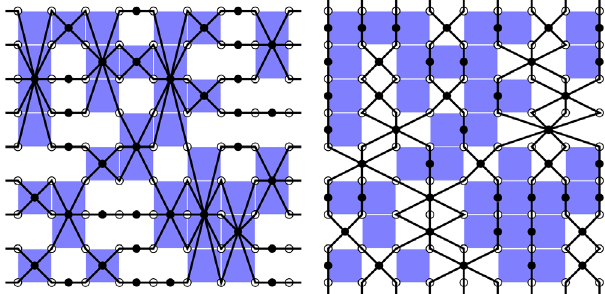
FIG. 4. The left-hand side represents the graph describing the two-body Ising model. The right-hand side represents its dual, the decoder graph. The blue squares represent cuts in the X -type stabilizers on a 9 × 9 lattice. The connectivity on the left-hand graph determines the sparsity on the right.